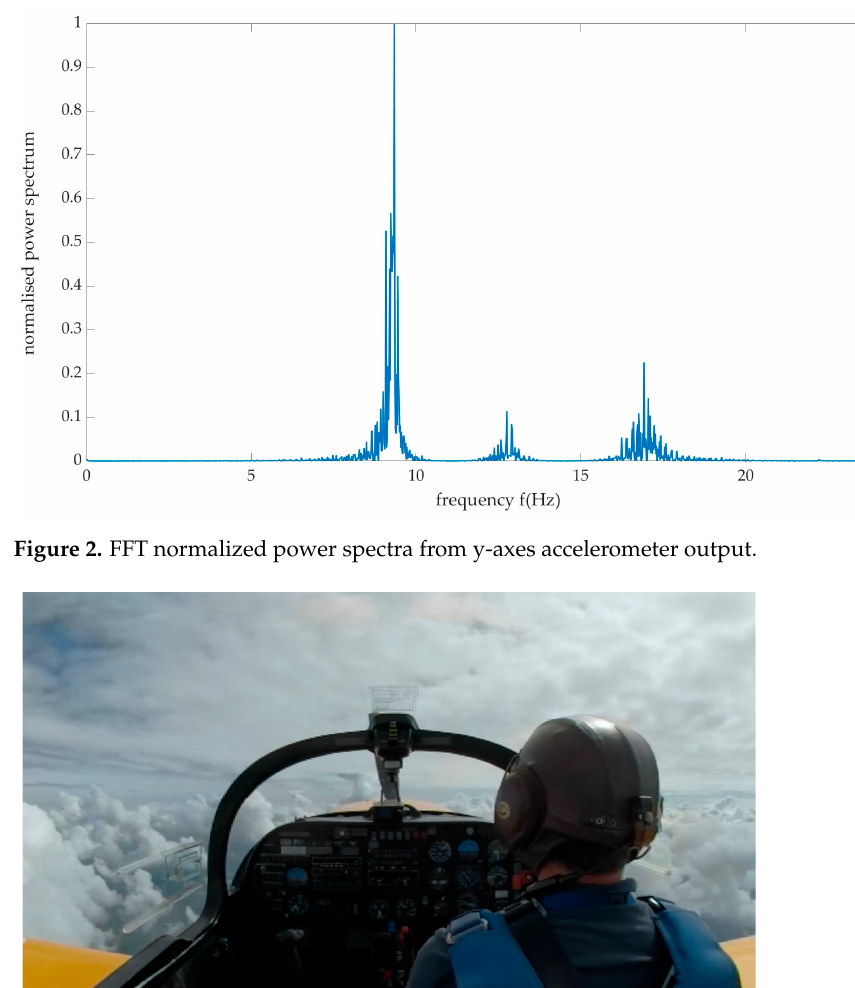
Figure 2. FFT normalized power spectra from y-axes accelerometer output.